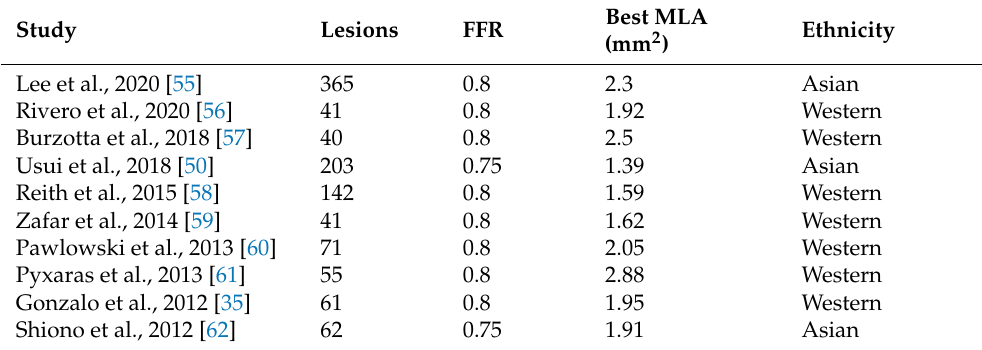
Table 2. Optical coherence tomography-derived optimal minimal luminal areas to predict ischemic fractional flow